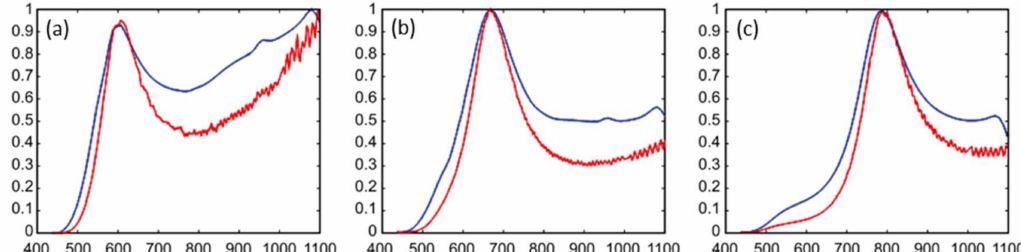
Figure 7. Normalized ratio of detector response (red) for each quad-detector array element ( a – c ) compared with the corresponding transmission spectrum (blue) of the MOE deposited directly on the Kapton tape